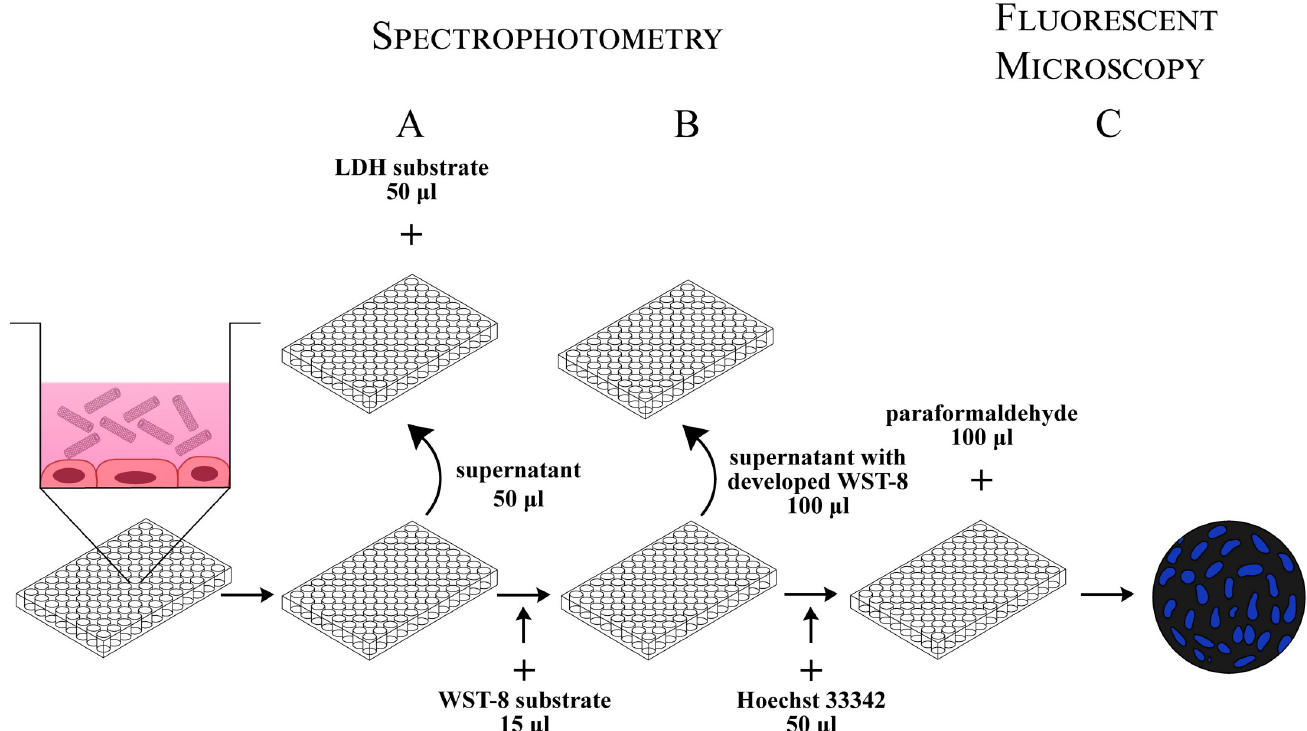
Fig 2. Workflow for the “three-in-one” cell death screening assay. HUVECs growing in the 96-well plate for 48 hours are exposed to NPs for 24 hours. Three types of cell death are evaluated simultaneously. A) Cell necrosis is measured spectrophotometrically after mixing an aliquot of cell supernatant with LDH substrate. B) Cell viability is assessed by adding WST-8 substrate to the cells. After three hours of incubation, aliquots of the reaction mixture are transferred into the new plate and measured spectrophotometrically. C) Cell apoptosis is detected after incubating the cells with Hoechst 33342 and fixing them with paraformaldehyde. Images captured under the inverted fluorescence microscope are computationally processed with the specially designed ImageJ